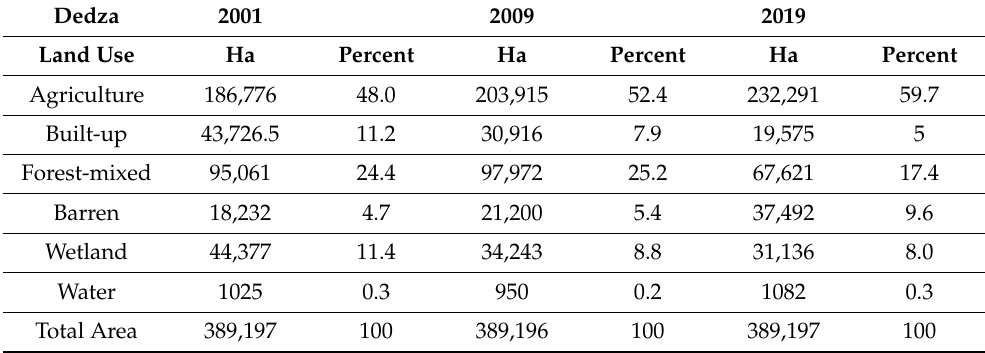
Table 4. Land cover distribution and statistics summary for Dedza district (Ha = Hectares).